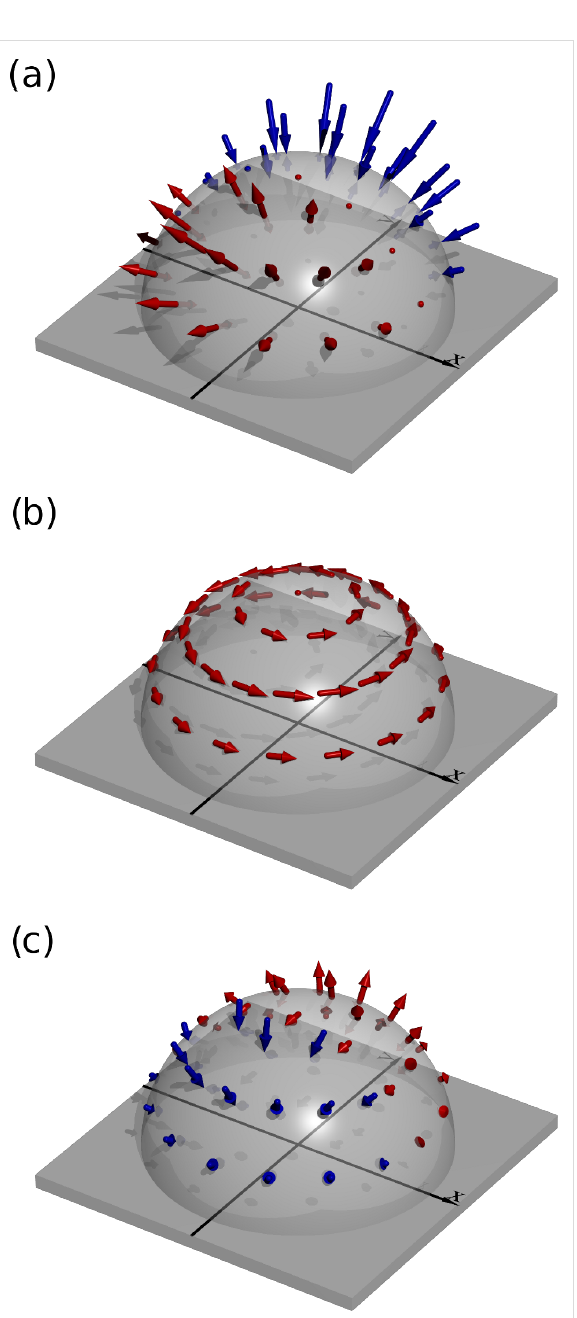
Figure 4: Calculated fluid flow around a beating cilium in the far-field approximation. Blue arrows indicate flow towards the cilium and red away from it. (a) The leading term in Equation 4 is the main contribu- tion to the generated fluid flow. (b) The visualisation of the second term shows that this term contributes only to vortical motion. The second and the third term in Equation 4 do not contribute to the directed fluid flow as their contributions average out (third term is not shown). (c) Visualisation of the fourth term in Equation 4, which has to be taken into account when calculating the generated fluid